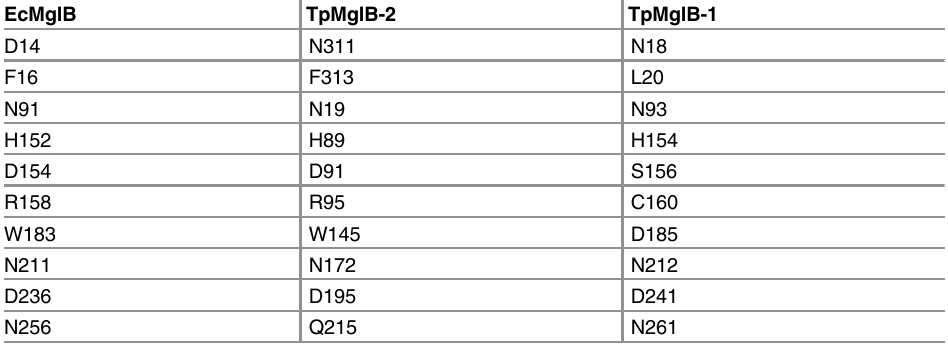
Table 2. Glucose-binding residues from EcMglB and their equivalents in TpMglB-2 and TpMglB-1.